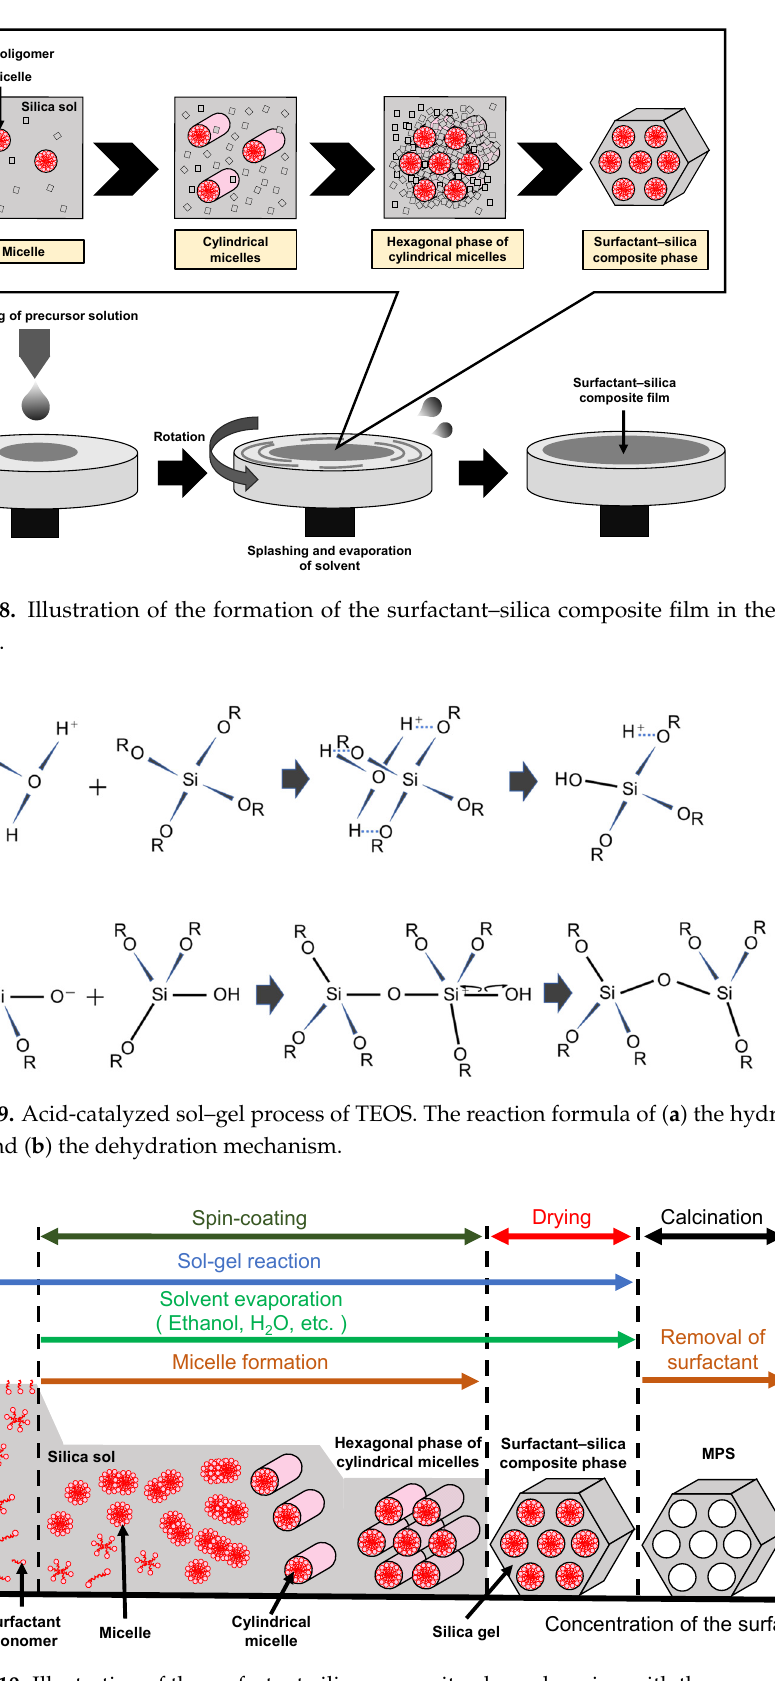
Figure 10. Illustration of the surfactant-silica composite phase changing with the concentration of the surfactant in the spin-coating and calcination processes.